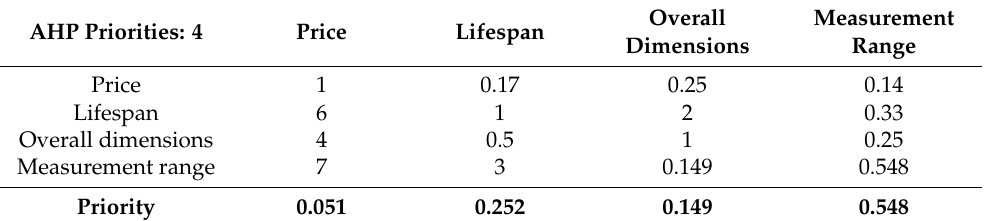
Table 3. AHP analysis for the criteria used in the selection of